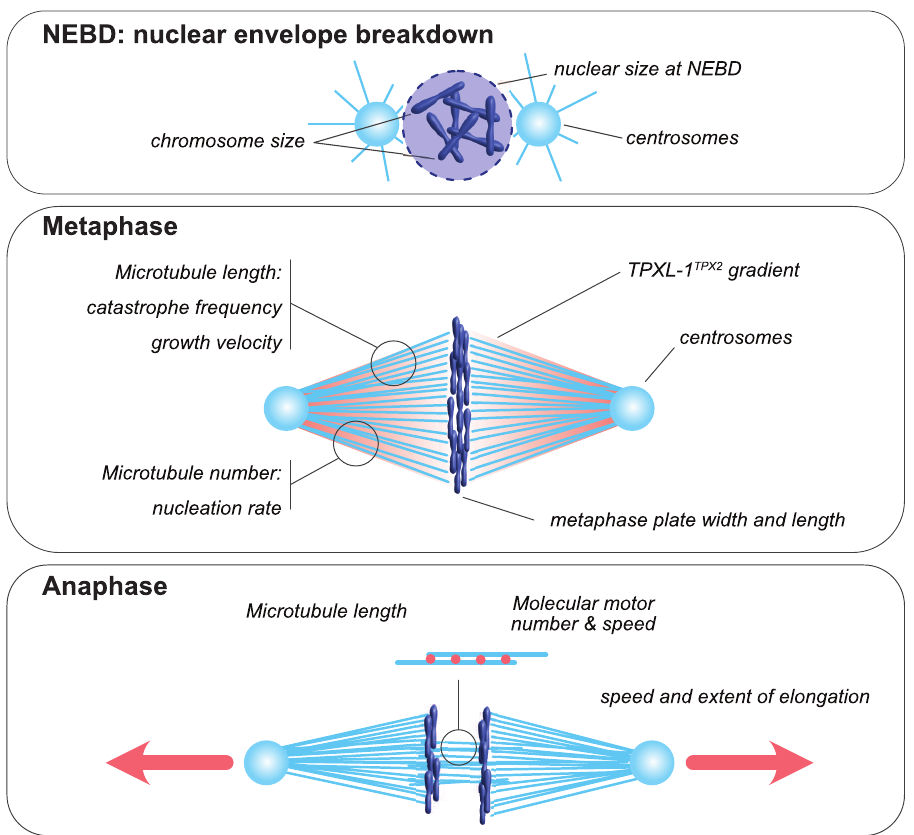
Figure 1. Mitotic spindle components that scale with cell size. At nuclear envelope breakdown, (NEBD, upper panel), chromosome dimensions [30,31] and the size of the nucleus scale with cell size [32–36]. In metaphase (middle panel), the dimensions of the metaphase plate adapt to cellular dimensions [6,31,37]. Centrosome size and a TPXL-1 TPX2 gradient scale with cell size [4,38]. The microtubule number, through autocatalytic amplification, scales with the surface area-to-volume ratio to set spindle mass [8]. Spindle microtubule length scales with cell size and is adapted to spindle length [39]. This is achieved by changes in catastrophe frequency [9] and by the scaling of microtubule growth velocity [7,8]. During anaphase (bottom panel), the speed and extent of spindle elongation both scale with cell dimensions